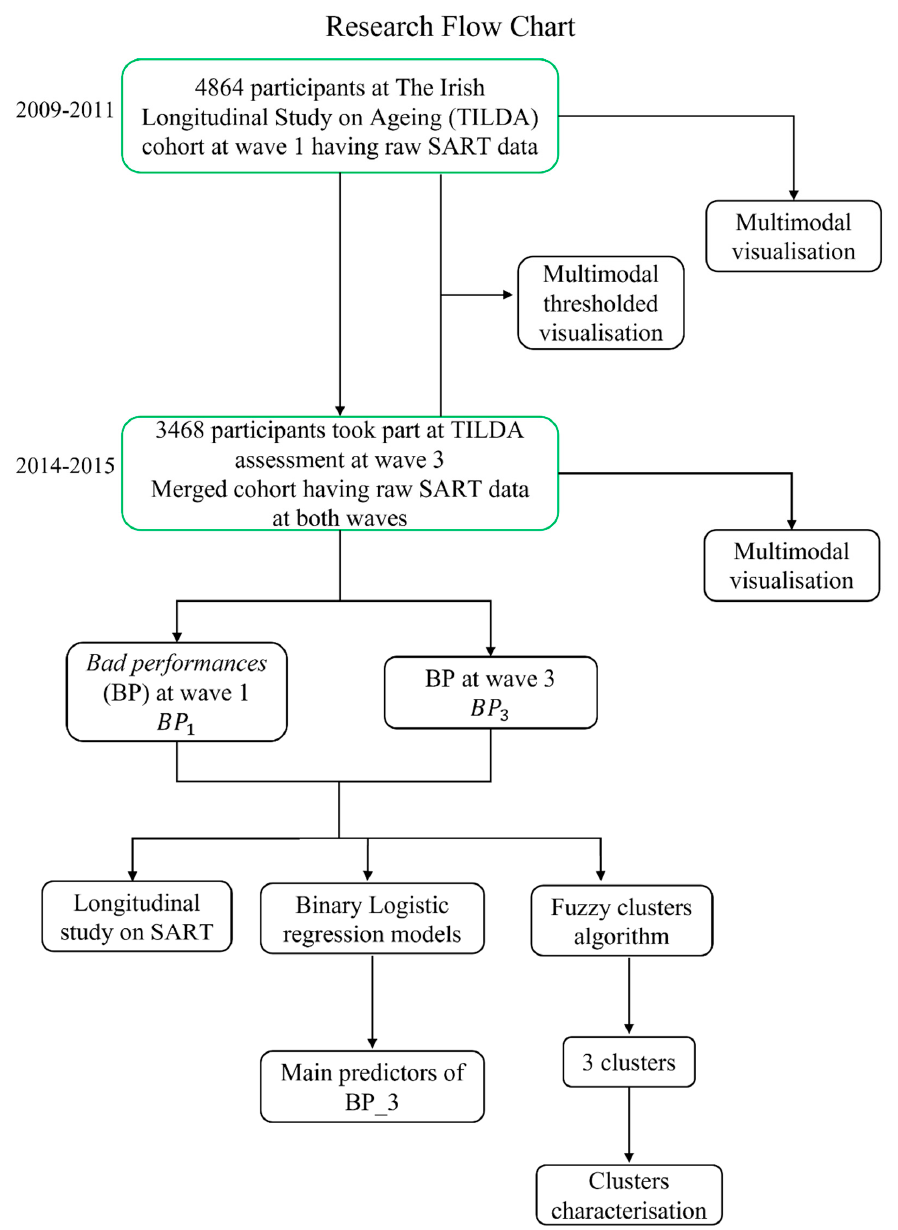
Figure 1. Research flow chart, where the input and output at every phase of analysis are detailed. The flow chart has a color-code: green for data collection, black for output and steps of the analysis, blue for figures and red for tables.